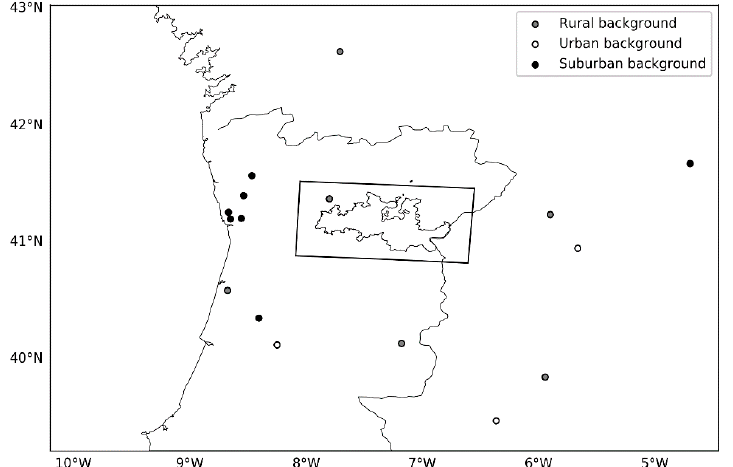
Figure 4. Location of the air quality monitoring stations considered for the model validation. The rectangular shape is the area of the D04 domain (1 × 1 km 2 ). Table 3. List of stations used in model validation and its